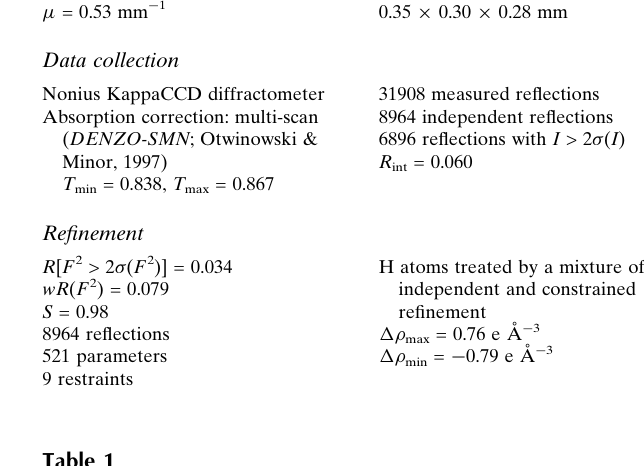
Selected geometric parameters (A˚ , (cid:2)